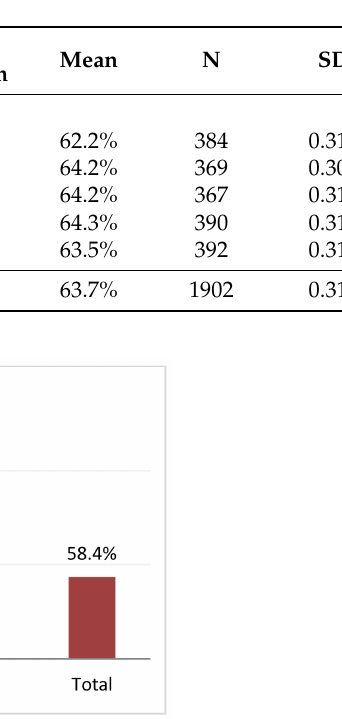
Table 5. Efficiency scores by year.